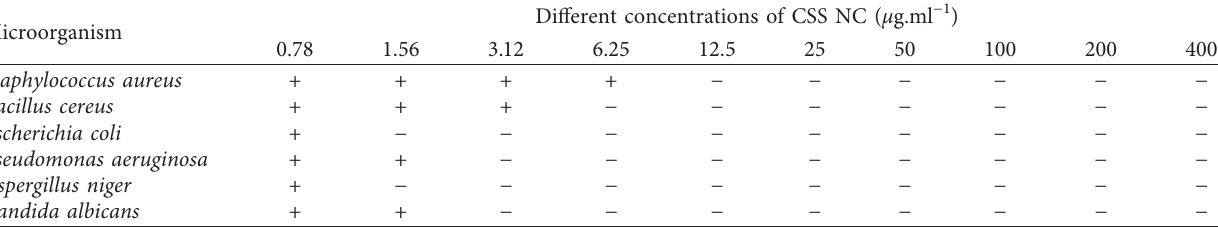
Table 4: The minimum inhibitory concentration (MIC) of microbe’s CSS NC in different concentrations (measured in µ g.ml-1). Microorganism